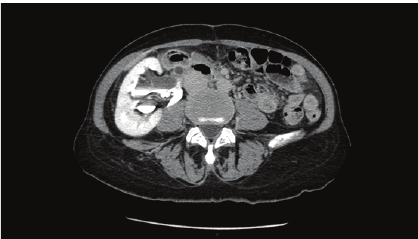
Figure 1: Right hydroureteronephrosis with delay in opacification of right urinary system.